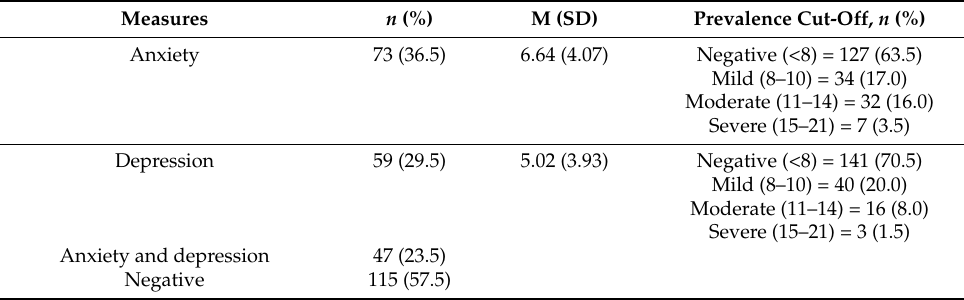
M: mean. SD: standard